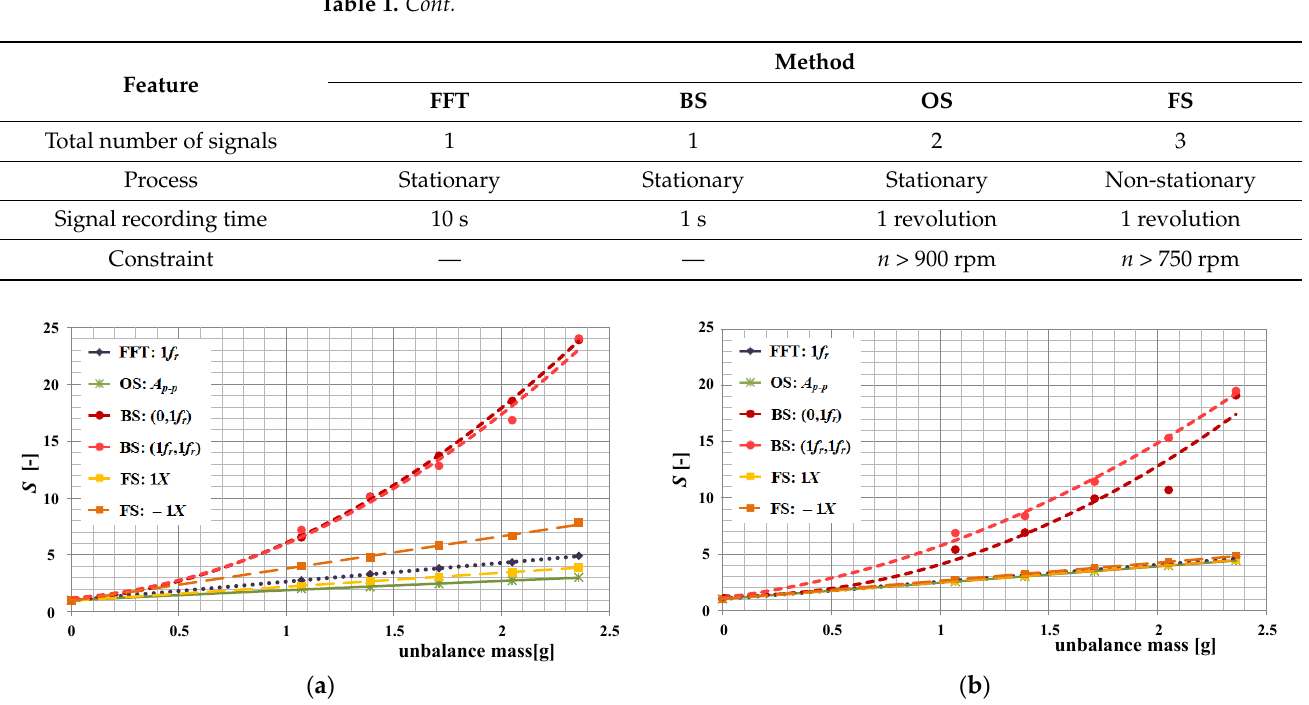
Figure 16. Effectiveness symptom as a function of unbalance mass changes: speed n 4 = 900 rpm ( a ); speed n 6 = 1500 rpm ( b ). Table 1. Comparison of properties of methods used for diagnosis of PMSM unbalance.